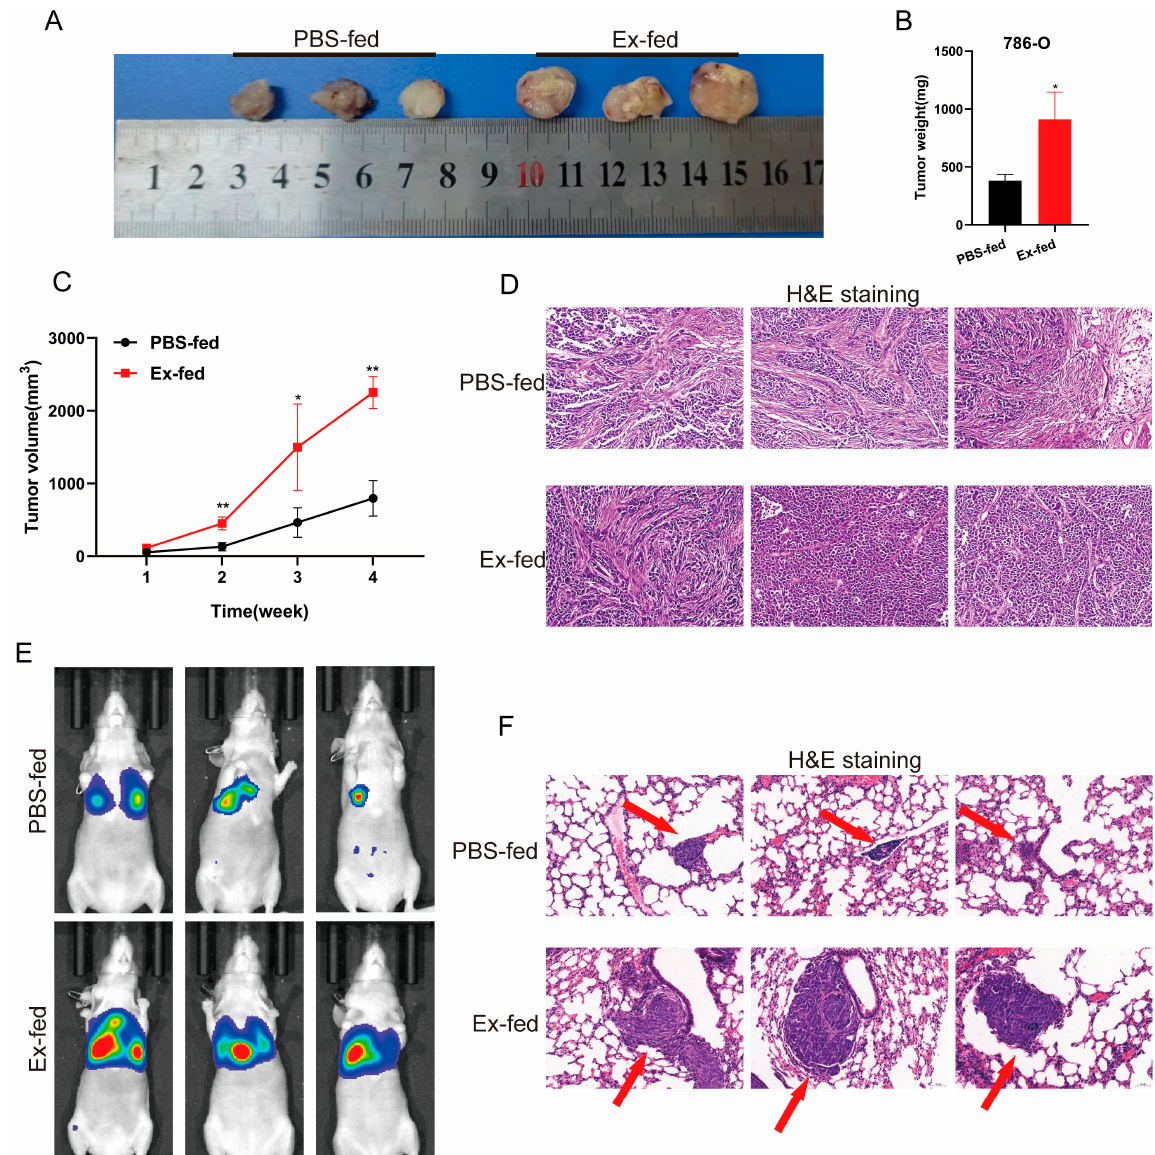
Figure 4. Caki-1-derived exosomes could promote the tumorigenicity and metastasis of RCC in vivo. ( A ) Tumors collected from nude mice were exhibited (n = 3 per group). ( B ) The tumor weight of PBS or exosomes treatment groups were measured and analyzed. ( C ) The tumor volume curve of the PBS or exosomes treatment groups were measured and analyzed. ( D ) Representative H&E staining of xenograft tumors in the PBS-fed or Ex-fed group. Scale bar, 50 µ m. ( E ) Representative images of nude mice injected with PBS or exosomes treated 786-O cells via the tail vein (n = 3 per group). ( F ) Representative H&E staining of lung tissues in metastasis models. Scale bar, 50 µ m. (* p < 0.05, ** p <